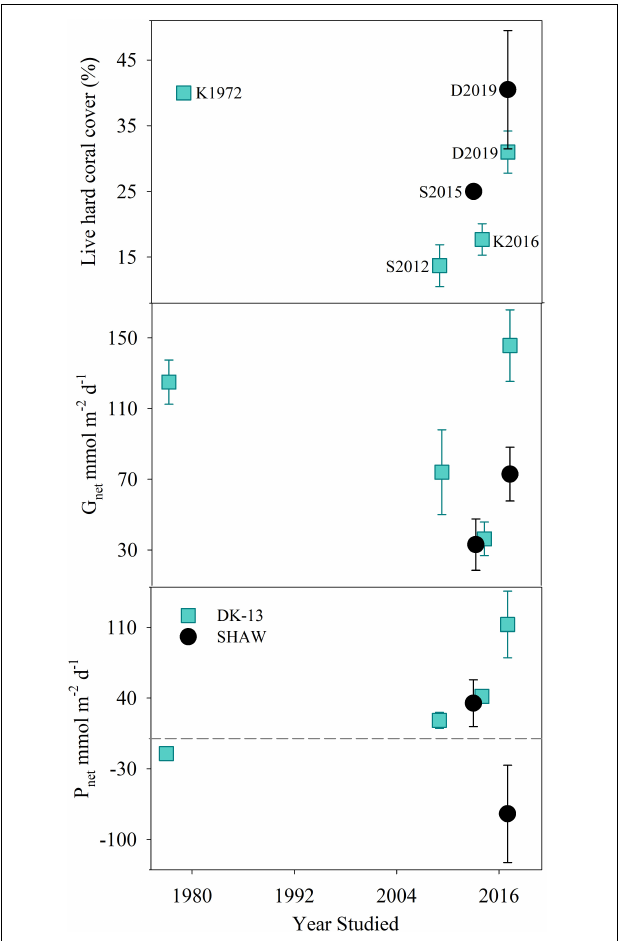
FIGURE 6 | Estimated coral cover, G net , and P net rates ( ± SE) at the DK-13 and SHAW sites over time. Dotted line represents net 0 production for P net . K1972 refers to Kinsey (1972); S2012 refers to Silverman et al. (2012); K2016 refers to Kwiatkowski et al. (2016); S2015 refers to Shaw et al. (2015), and D2019 refers to this